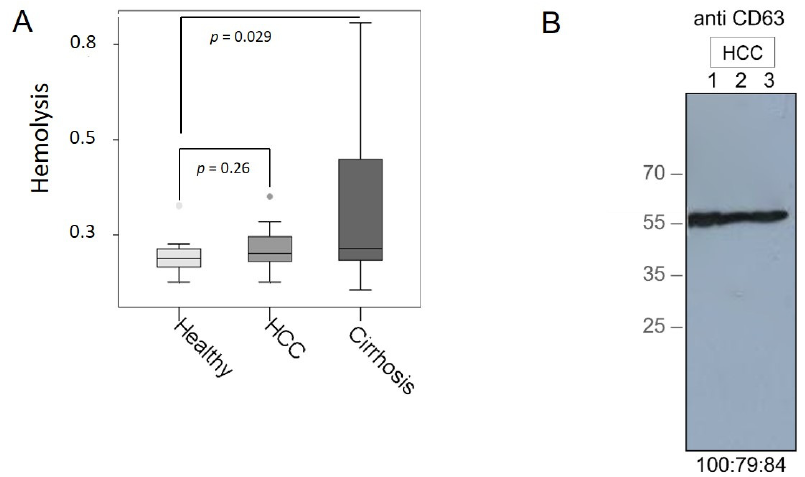
Figure 1. Verification of plasma samples and exosomes. Hemolysis was assessed by spectrophotome- try at wavelengths from 350 to 650 nm. The degree of hemolysis was determined based on the optical density (OD) at 414 nm (absorbance peak of free hemoglobin, called Soret band), with additional peaks at 541 and 576 nm. Samples were classified as being hemolyzed if the OD at 414 exceeded 0.3. The box blot shows the levels of hemolysis in plasma samples from HCC and liver cirrhosis patients compared with those from healthy individuals with the p -values ( A ). Exosomes were precipitated from 3 plasma samples of HCC patients by the agglutinating agent ExoQuick and analyzed by a Western blot using an antibody specific for the exosomal marker CD63. The percentages under the blot show intensities of the areas of three bands ( B ).